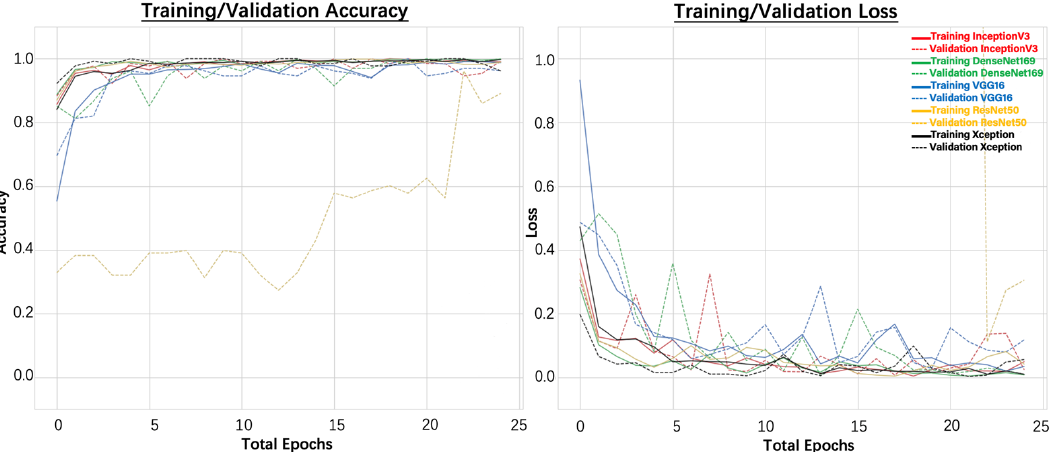
Figure 6. Training and validation accuracy and loss plots for training deep learning models to identify diseased regions using tile segments of size 1000 × 1000 pixels. Table 5. Testing accuracies and testing loss when tile size of 1000 × 1000 pixels was used.